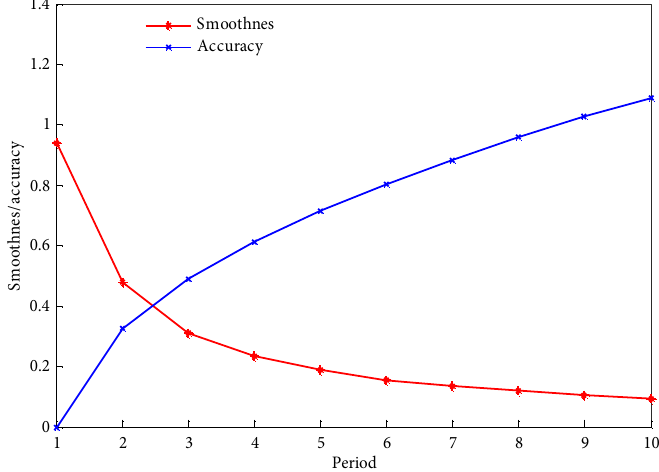
Fig. 2. Smoothness and accuracy of SMA plotted as two